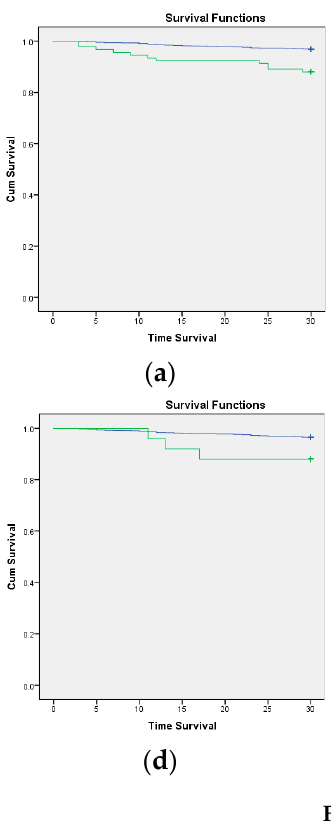
Figure 2. Kaplan–Meier curve of the 30-day survival rate of comorbidity in geriatric patients. The green line indicates patients with comorbidities, and the blue line indicates patients with no comorbidities. ( a ) Moderate-to-severe renal disease (log-rank p ≤ 0.01); ( b ) cerebrovascular disease (log-rank p ≤ 0.01); ( c ) diabetes with chronic complications (log-rank p = 0.03); ( d ) metastatic solid tumor (log-rank p = 0.02); ( e ) dementia (log-rank p ≤ 0.01), and ( f ) rheumatologic disease (log-rank p = 0.03).